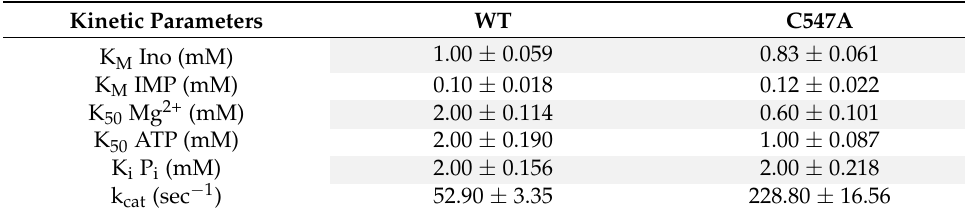
Table 1. Kinetic parameters of the wild-type (WT) and C547A recombinant